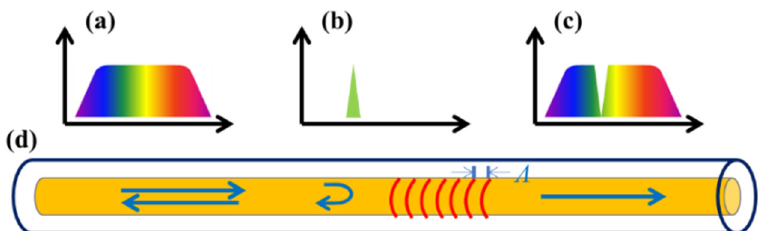
Figure 1. The schematic diagram of an FBG. ( a ) Incident spectrum. ( b ) Reflectance spectrum. ( c ) Transmission spectrum. ( d ) Optical fiber.